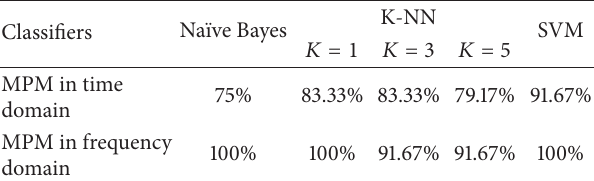
Table 3: Classification